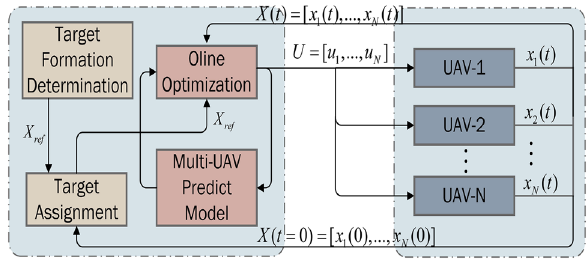
Fig. 9 Schematic of AHPSODE-based RHC controller